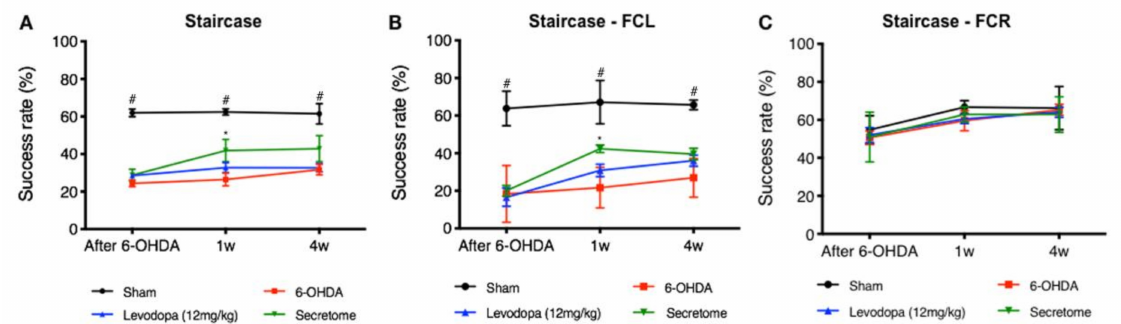
Figure 3. Impact of hBM-MSCs secretome and levodopa interventions on motor coordination performance of 6-OHDA PD animals—staircase. ( A ) The paw reaching motor coordination performance oftheanimalsdemonstratedasignificantamelioration(atoneweek, p < 0.05)oftheforelimbcoordination of the hBM-MSCs secretome-injected animals when compared to the untreated group 6-OHDA. Even under a ( B , C ) paw reaching forced-task, the animals injected with hBM-MSCs secretome presented a better performance (at one week after injection; p < 0.05) when compared to the untreated group 6-OHDA on the ( B ) (left) a ff ected side (FCL). Such pieces of evidence, were, in turn, not observed in the levodopa-treated animals when compared to the untreated group 6-OHDA ( A – C ). Sham n = 9, 6-OHDA n = 7, Levodopa n = 5, and hBM-MSCs secretome n = 6. Data presented as mean ± S.E.M. *hBM-MSCs secretome-injected animals statistically di ff erent from 6-OHDA, p < 0.05; # Sham animals statistically di ff erent from 6-OHDA, hBM-MSCs secretoma and levodopa-injected animals, *** p < 0.001. FCR—forced choice task at right side; FCL—forced choice task at left